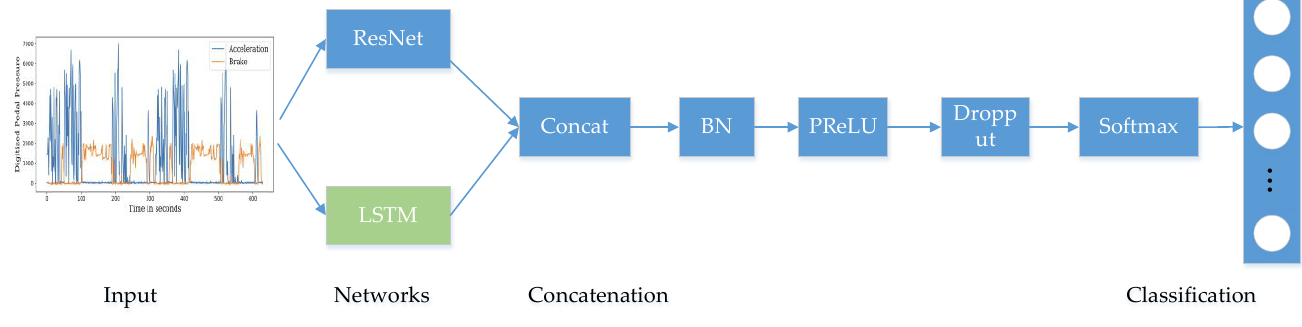
Figure 11. The hybrid model adopted from [97].